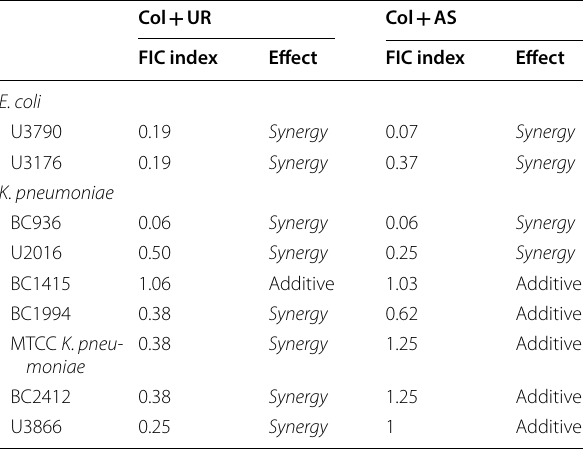
Table 1 Ursolic acid exhibits synergy with colistin against most of the strains of Escherichia coli and Klebsiella pneumoniae Col +